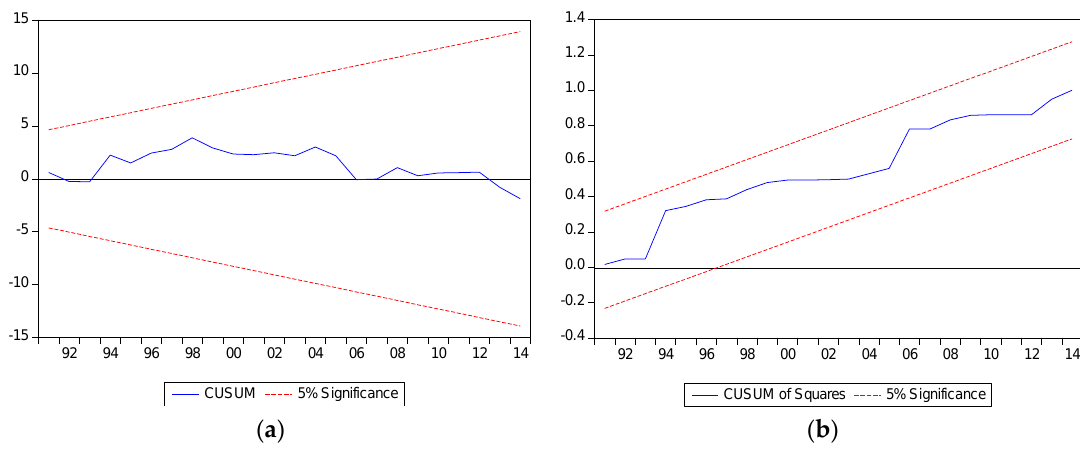
Figure 2. ( a ) CUSUM and ( b ) CUSUMSQ stability graphs in the case of model 2.